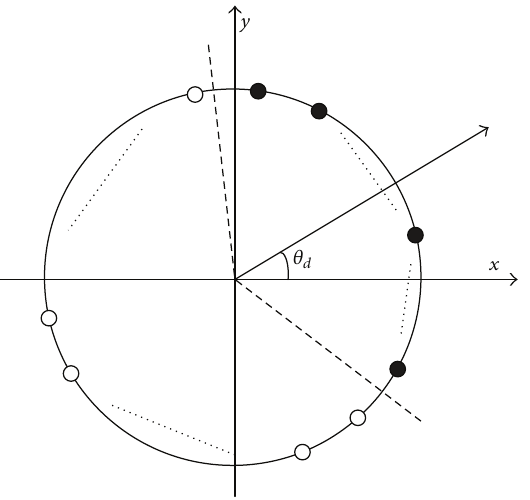
Figure 2: Elements used in the beamforming for circular array.